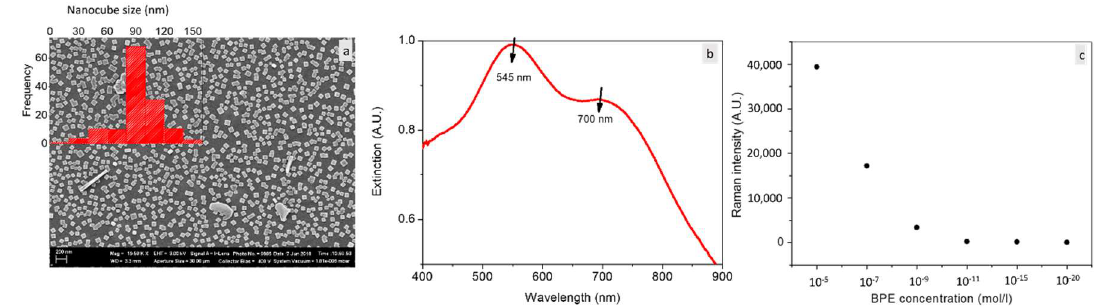
Figure 8. ( a ) SEM images for gold nanocubes prepared with 60 mM of NaAuCl 4 /ethanol/acetone combination upon spin-coating on ITO-covered glass substrate. The insert is a size distribution of the corresponding nanocubes performed by imageJ. ( b ) Extinction spectrum obtained for the GNC obtained in (a). ( c ) SERS intensity of the 1600 cm −1 band as a function of BPE concentration obtained for the same substrate over 0.5 s.